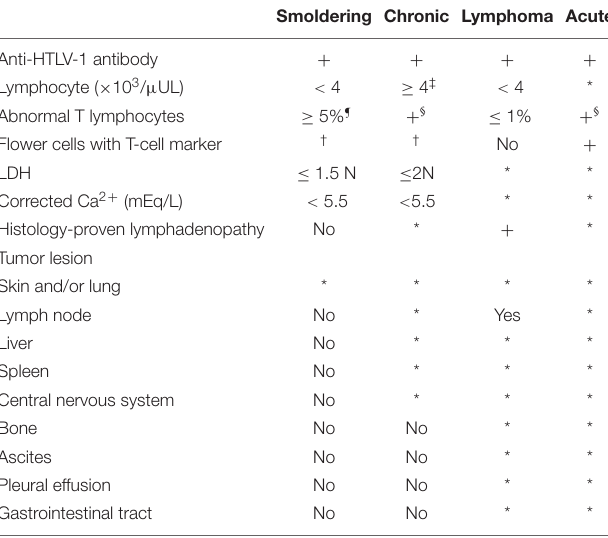
TABLE 1 | Diagnostic criteria for clinical subtypes of adult T-cell